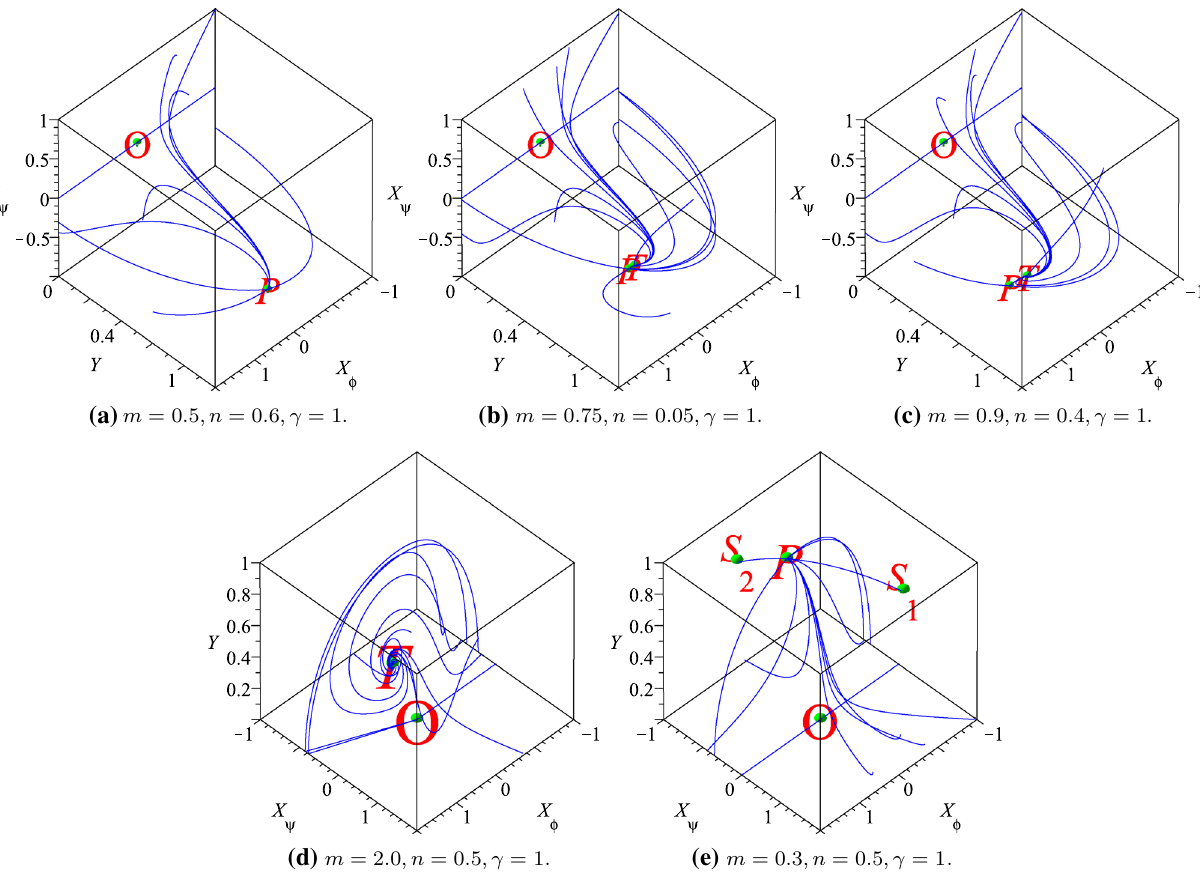
Fig. 3 Some orbits in the phase plane of the system (58), (59), (60) for the five choices of the parameters and ε = +